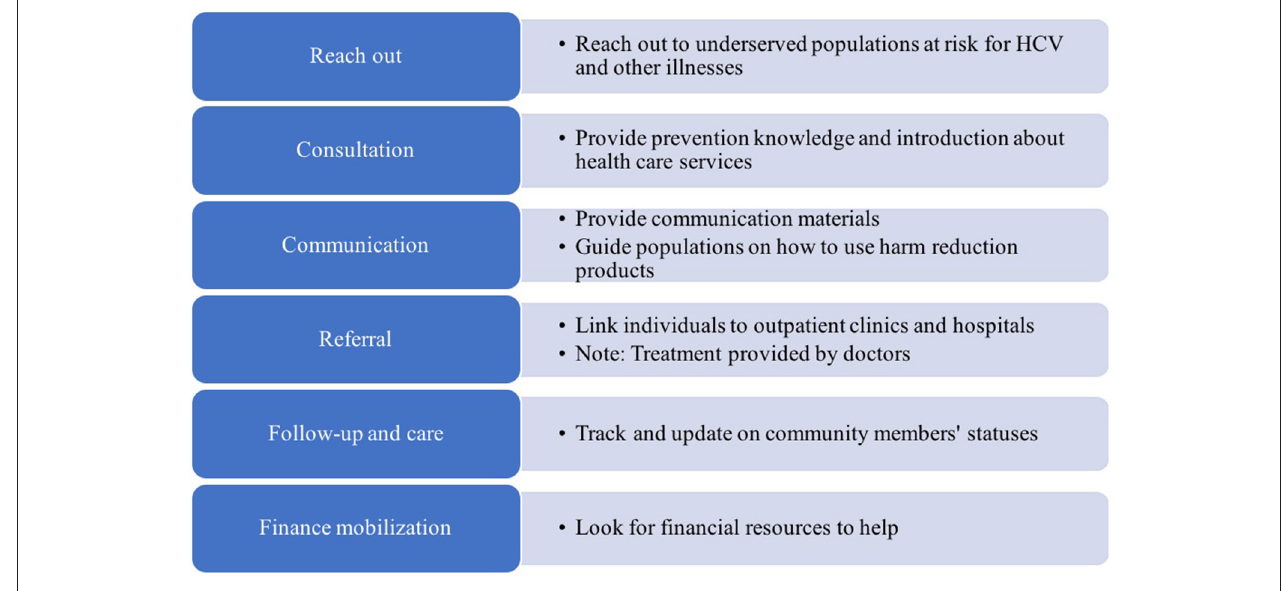
FIGURE 2 | Stakeholder activities, as defined in the CBO-level AG